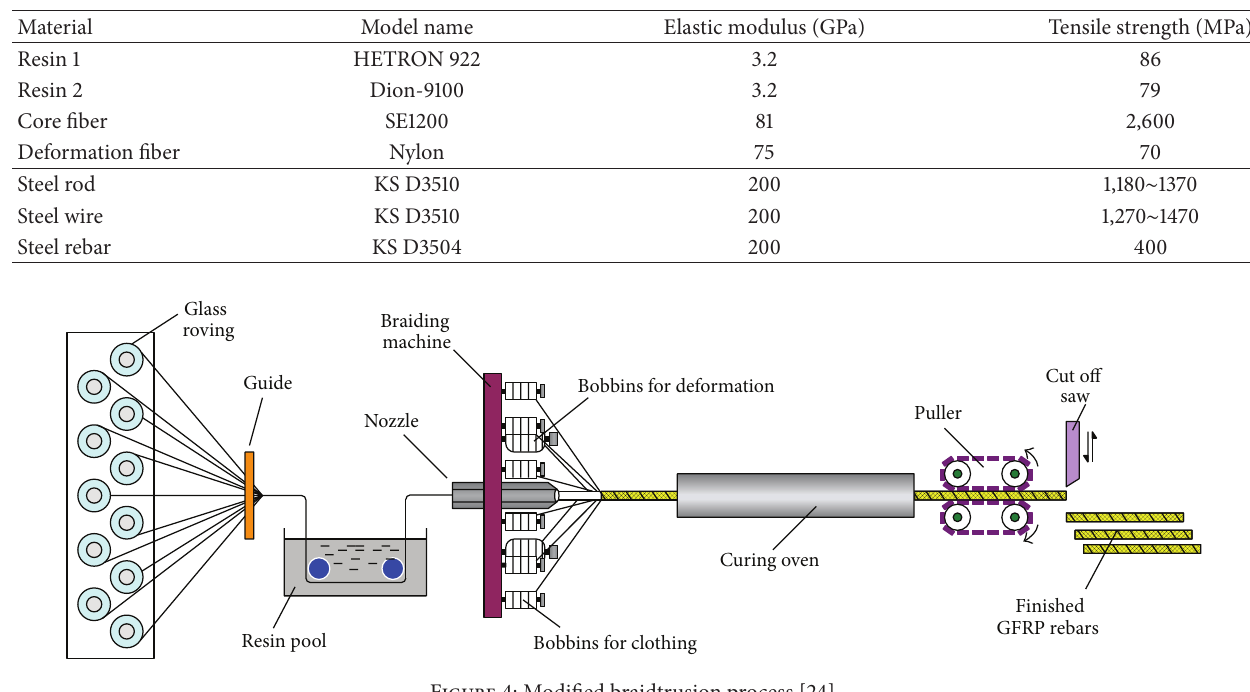
Table 2: Material properties for FRP Hybrid Bar.